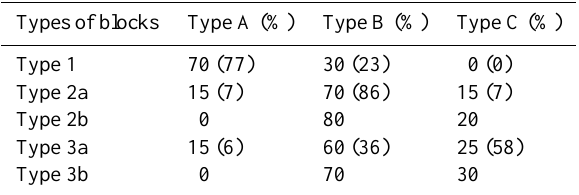
Table 2. Classification-2007 of the residential blocks according to the distribution of the different types of buildings (in